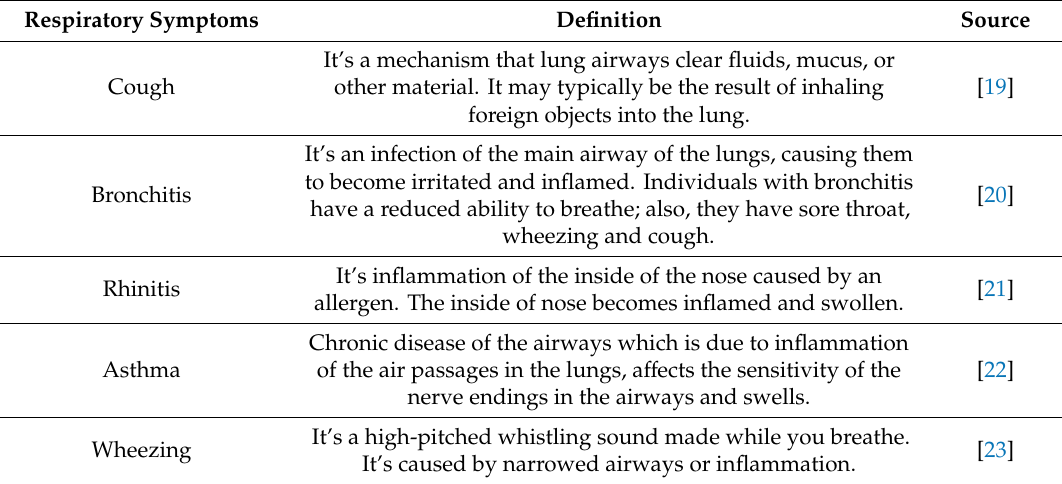
Table 1. Definitions of five nonmalignant respiratory